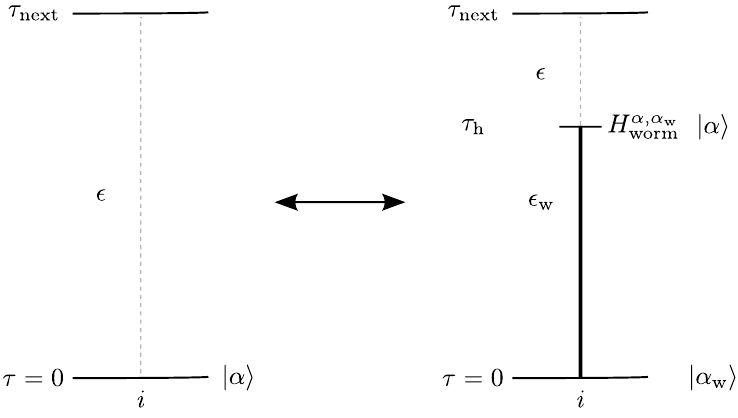
Figure 2: Insert / Delete worm from τ = 0. A worm is inserted at the τ = 0 edge by inserting a worm head at a randomly sampled time τ particle to the segment spanning the interval τ : [ 0, τ be inserted by placing a worm tail at the sampled time and destroying a particle in ) the segment τ : [ 0, τ t